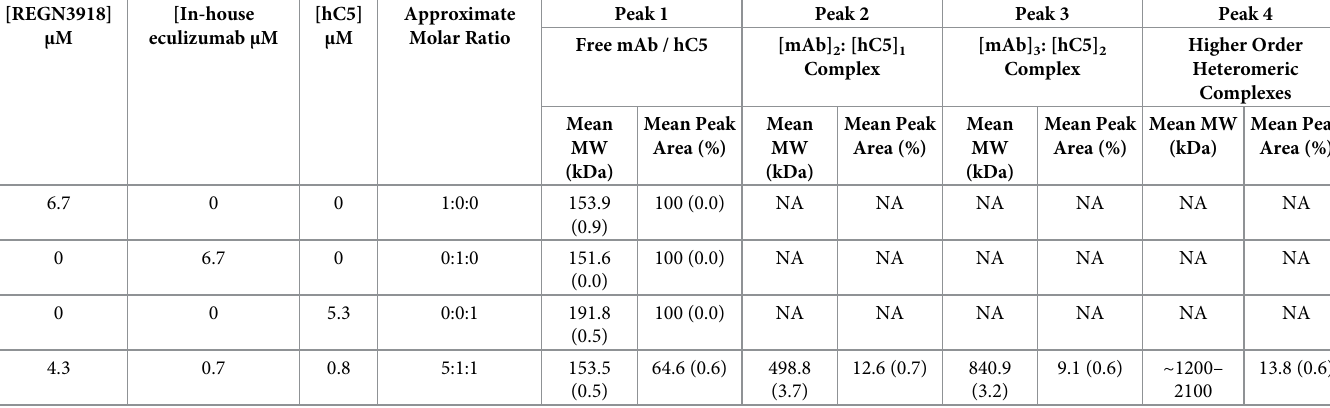
Table 3. Size distribution of heteromeric complexes formed by REGN3918, in-house eculizumab and C5.